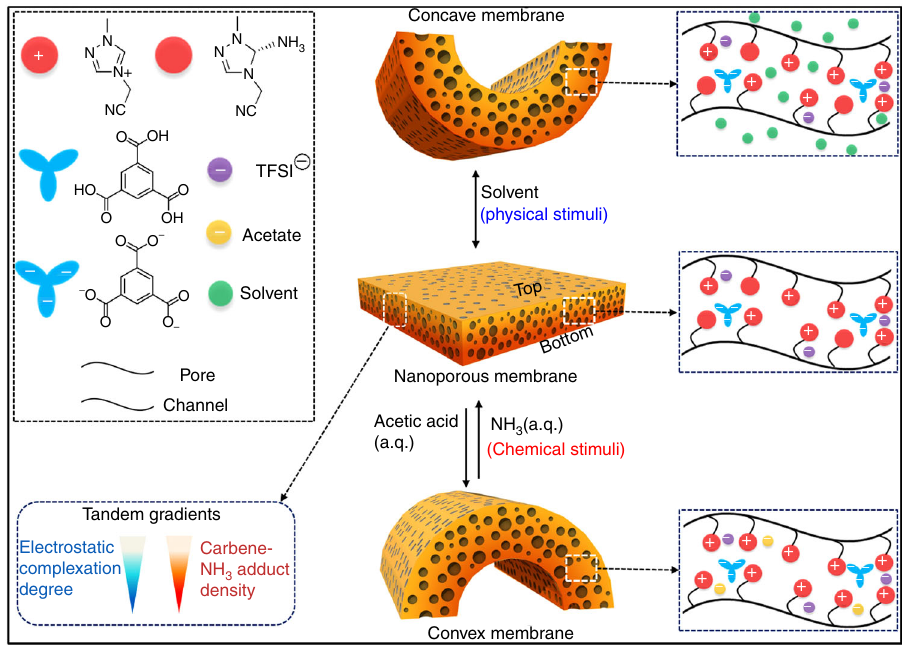
Fig. 5 Schematic illustration of bending mechanism derived from the tandem gradients of membrane actuator. Each gradient can independently respond to external chemical/physical stimuli, e.g., the EC degree gradient undergoes actuation once occurrence of solvent – Ptriaz interaction, leading to concave membrane with bottom surface outwards, while the CNA density gradient display actuation once reacting with proton, generating a convex membrane with bottom surface inwards. In the concurrent presence of these two stimuli, two competing bending actuations occur and the dominant one will determine the fi nal